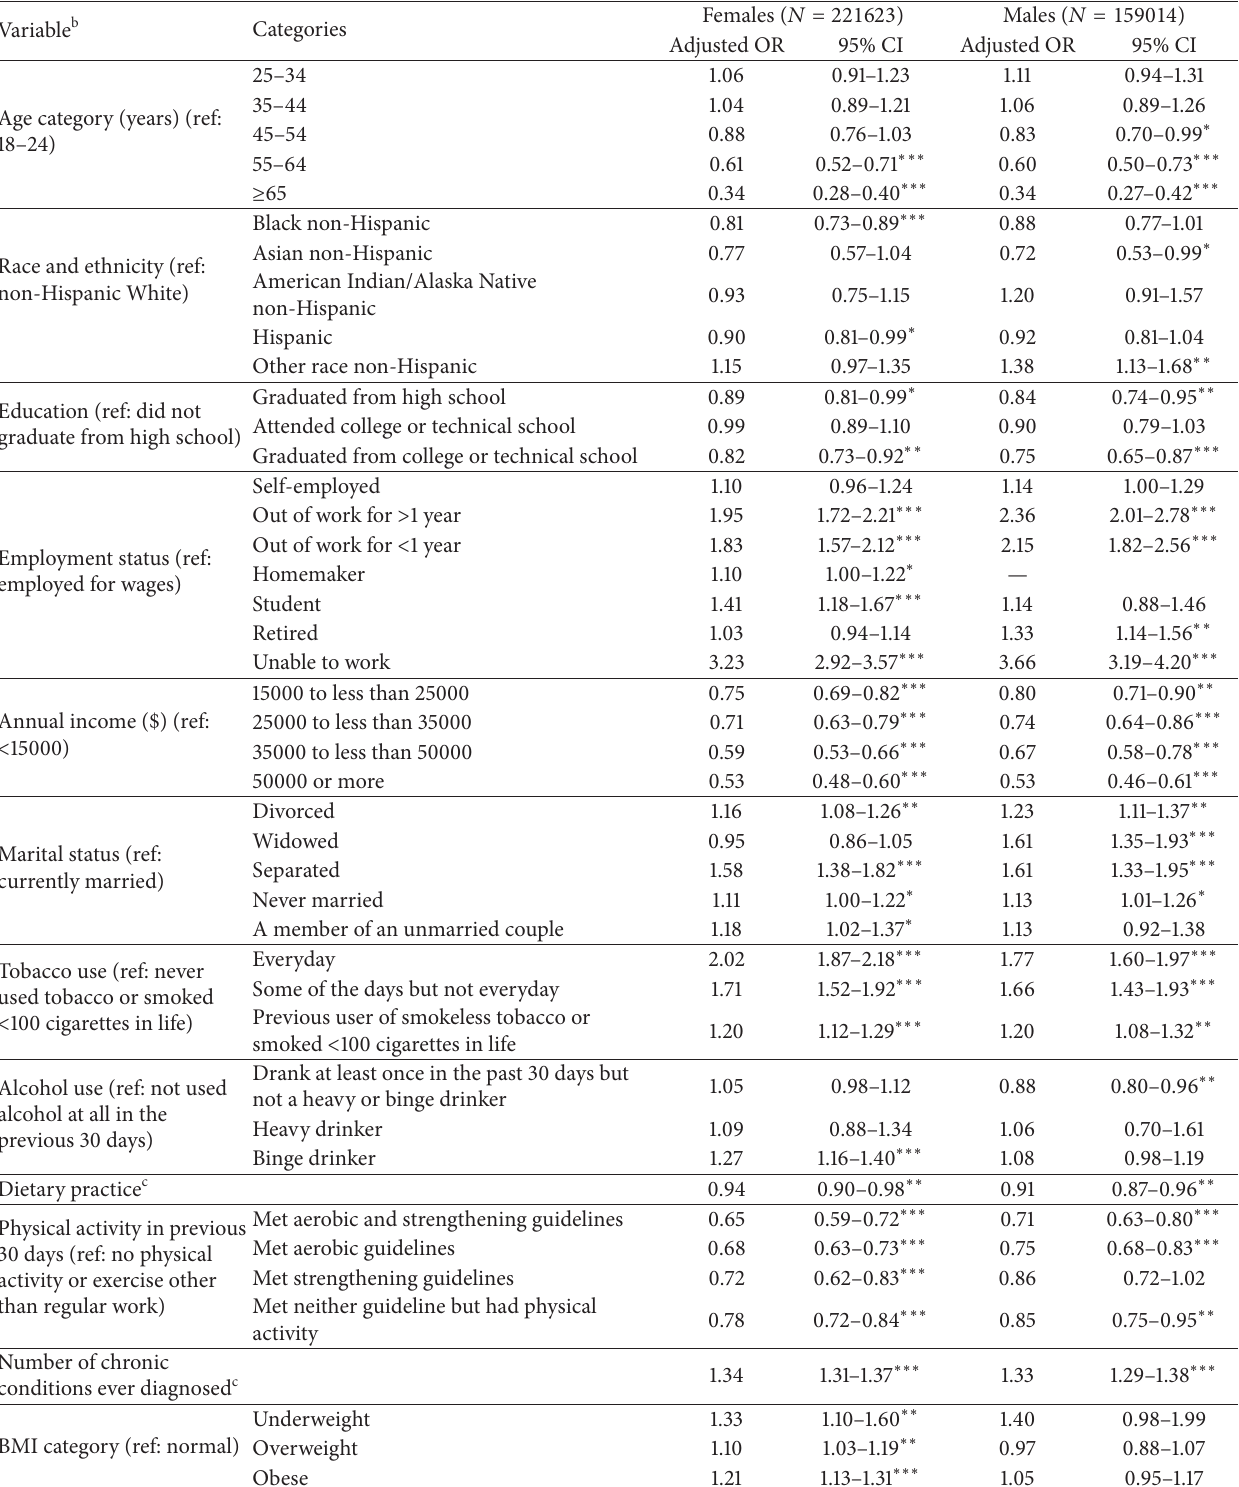
Table 5: Adjusted odds ratios a of having FMD among adults in the United States, stratified by gender, BRFSS 2011. Variable